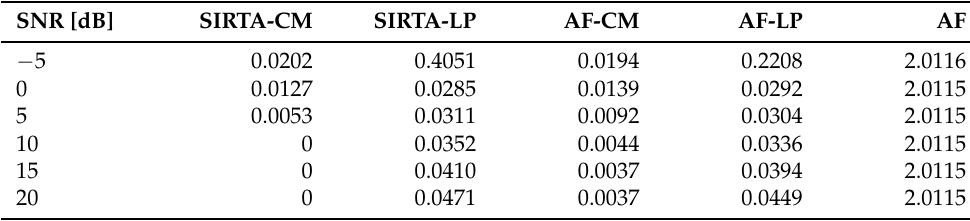
Table 2. Normalized Root Mean Square Error (NRMSE) for the first object.